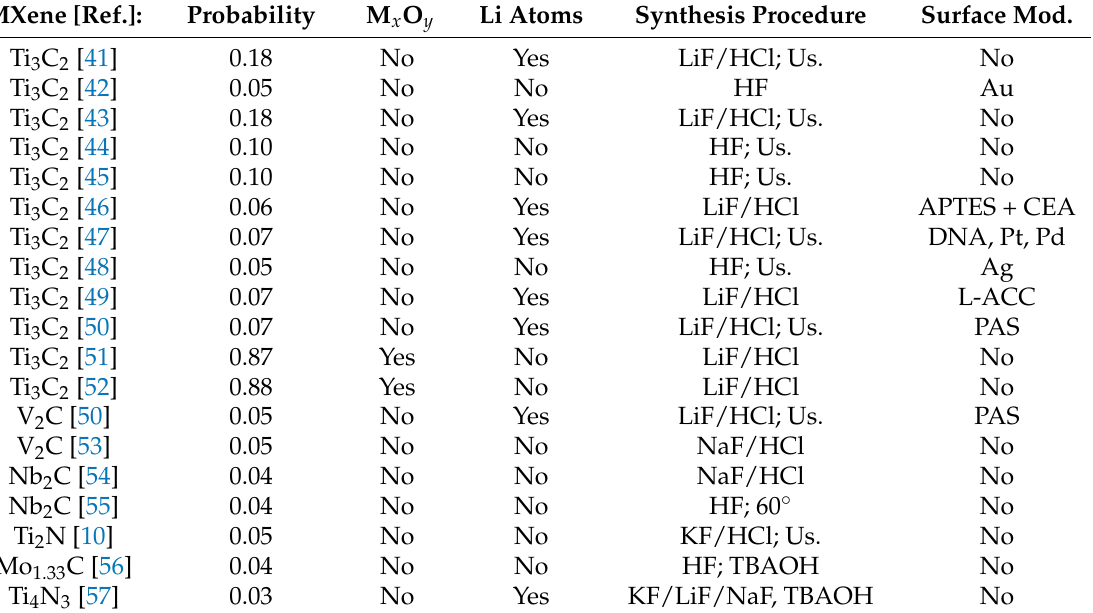
Table 3. Predicted probability of cytotoxicity score of various MXenes compounds. For each of the compounds different chemical treatment, as well as chemical composition on the surface have been reported. Thus, different probability scores have been obtained. All data taken from high-throughput screening experiments (see last column). The abbreviation Us. denotes Ultrasounds, whereas the the third and fourth columns denote the presence of the M x O y and Li atoms on the surface. Note, that two descriptors etching agent and delaminating agent are denoted here as the synthesis